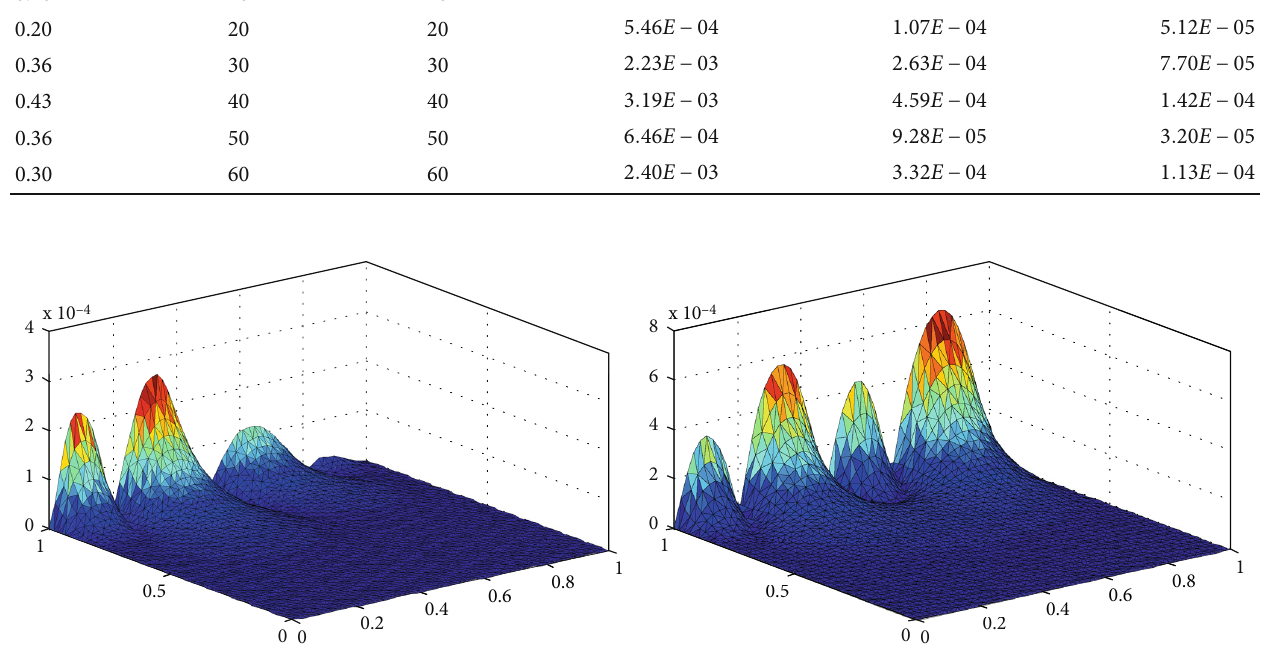
Figure 6: MAE for example 4.2 using MQ with ϵ = 0 : 44 for N = 60 × 60 (a) and IMQ with ϵ = 0 : 36 for N = 50 × 50 (b).